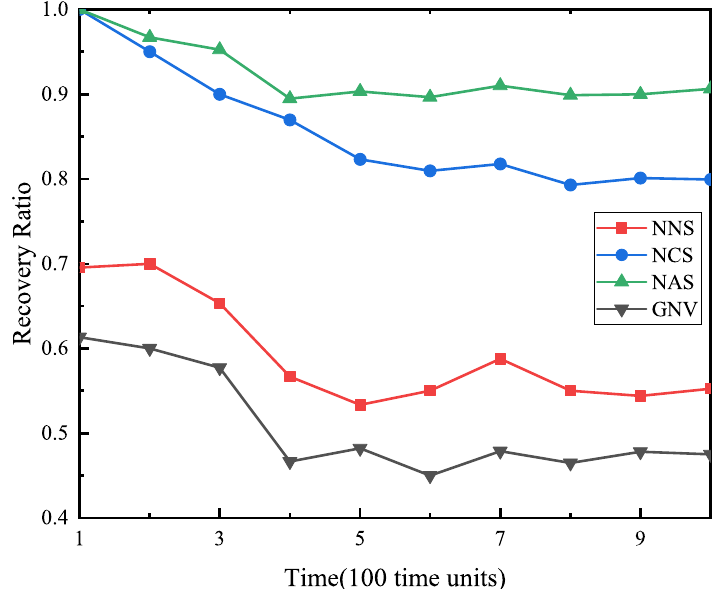
Figure 3. Failure virtual sensor network (VSN) recovery rate.